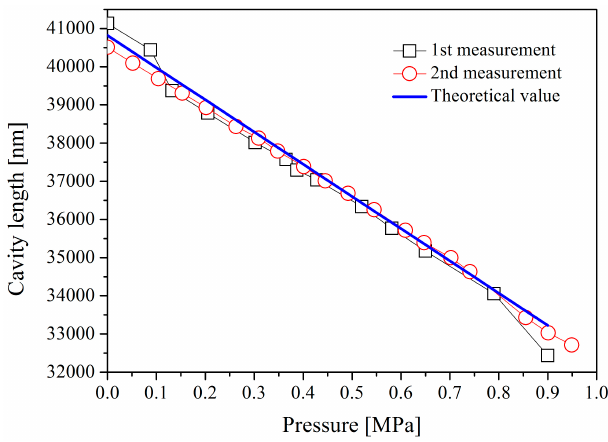
Figure 9. A standard interference spectrum of the EFPI pressure sensor with a cavity length of approximately 35 µm.